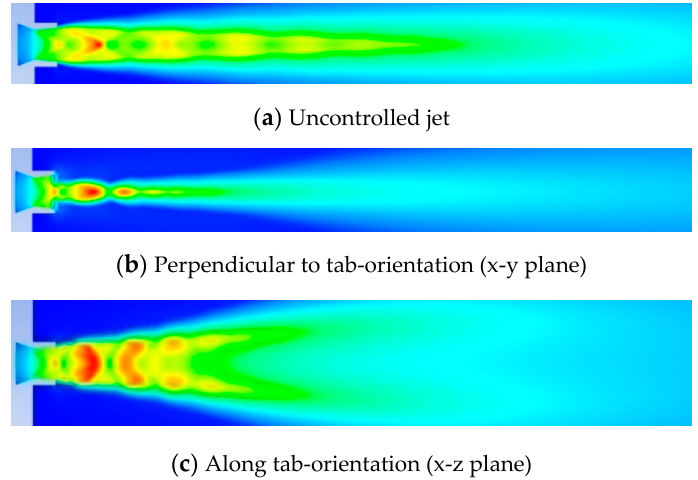
Figure 28. Mach contours of uncontrolled and controlled jets at NPR 8 (underexpansion).